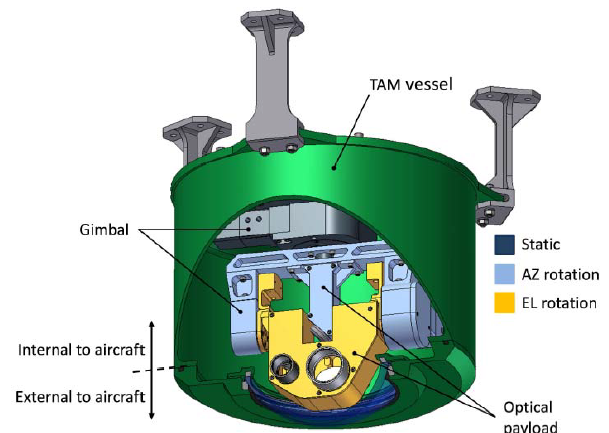
Figure 3. Cut-away model of the TAM showing the gimbal, pay- load, and the edge of the dome (in dark blue). The light-blue com- ponent rotates about the azimuthal axis, whilst the yellow compo- nent rotates about the axis of elevation. The TAM is 513mm tall including the legs and has a diameter of 555mm including the